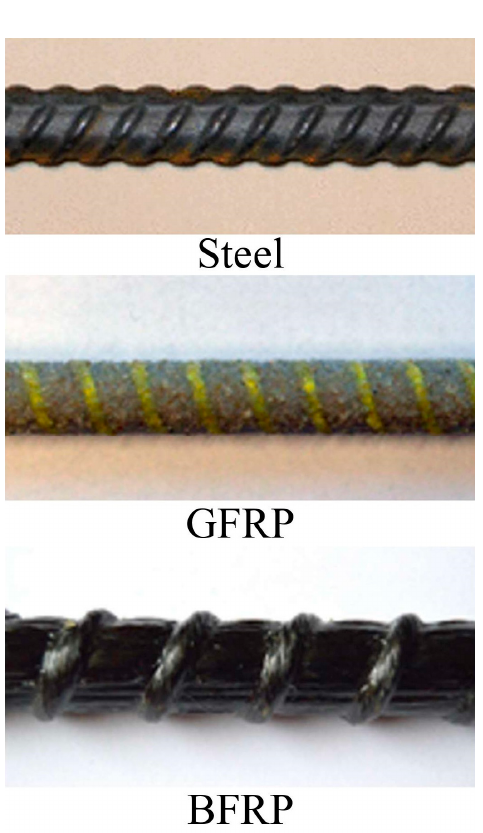
Figure 2. BFRP, GFRP, and steel